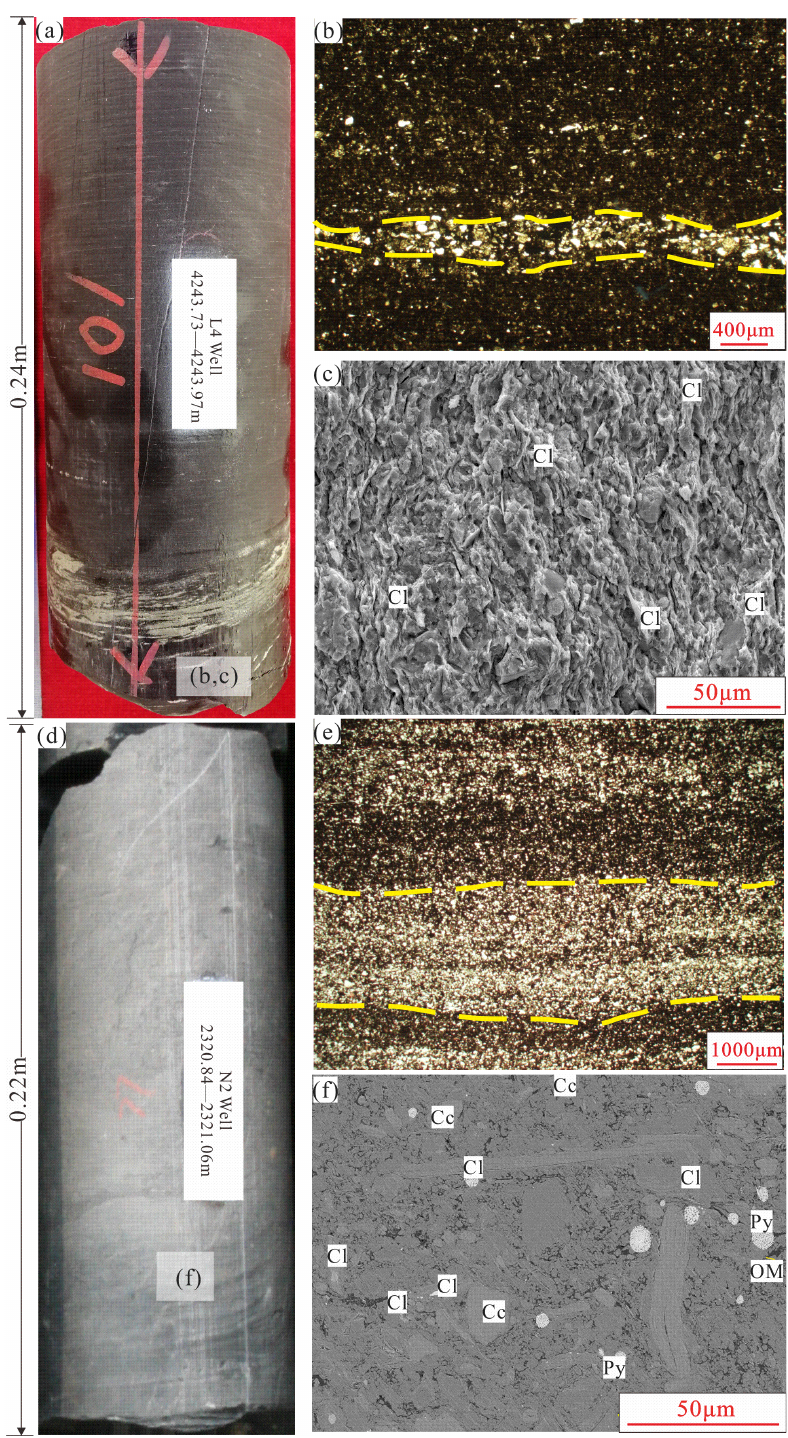
Figure 7. Core photographs, thin section photos and SEM images of gravity flow deposits in the Southern Sichuan Basin. ( a ) Massive shale with wavy siltstone laminae developed in core, 4243.9 m, L4 well, ( b ) lenticular debris aggregates mixed with dark organic matter, thin section photo, 4243.9 m, L4 well, ( c ) xenomorphic clastic clays filled in the primary pore, SEM image, 4243.9 m, L4 well, ( d ) typical eroded cross bedding observed from core, 2320.9 m, N2 well, ( e ) coarse silt mixed with terrigenous clay scours and erodes underlying argillaceous deposits in thin sections, 2320.9 m, N2 well, ( f ) disordered flake-like illite in primary